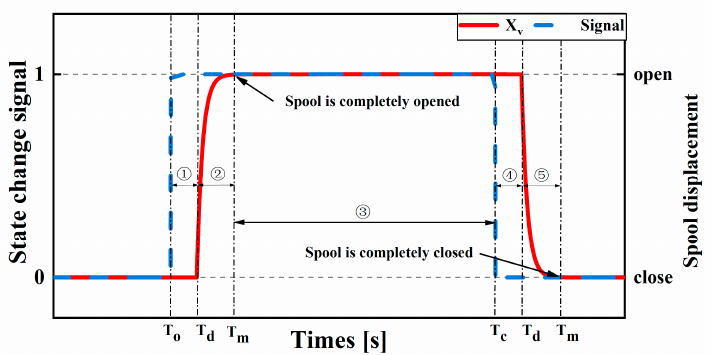
Figure 2. FDV dynamics response characteristic: ① : the spool opening delay stage; ② : the spool opening moving stage; ③ : holding opening stage; ④ : the spool closing delay stage; ⑤ : the spool closing moving stage.